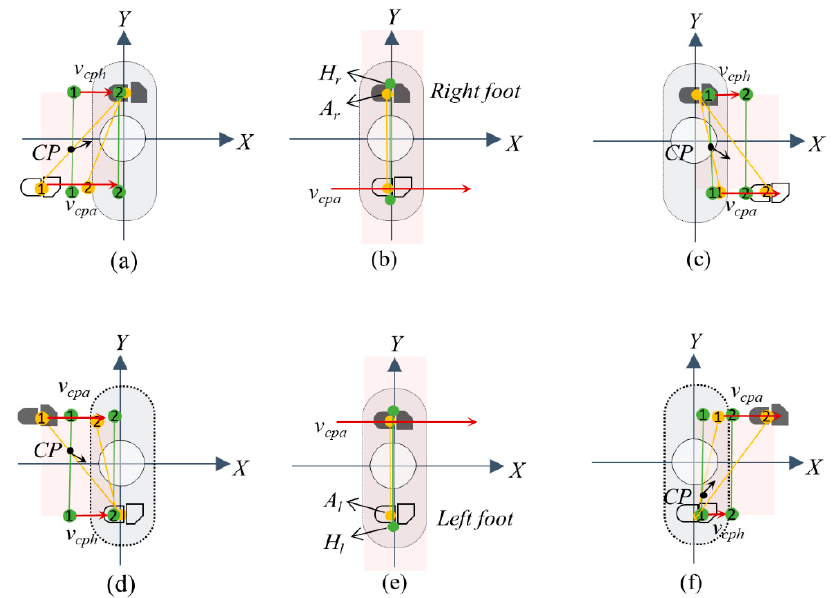
Figure 2. Six expected stages depending on the placement between H r(l) and A r(l) in the xy -plane; the red shadow area is a potential area for the CP; ( a – c ) in the right stance state, and ( d – f ) in the left stance state: ( a ) Increased y cp with time; ( b ) overlap of L a and L h ; ( c ) decreased y cp with time; ( d ) decreased y cp with time; ( e ) overlap of L a and L h ( f ) increased y cp with time.